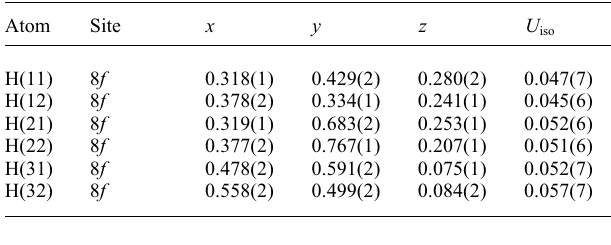
Table 2. Atomic coordinates and displacement parameters (in Å 2 )